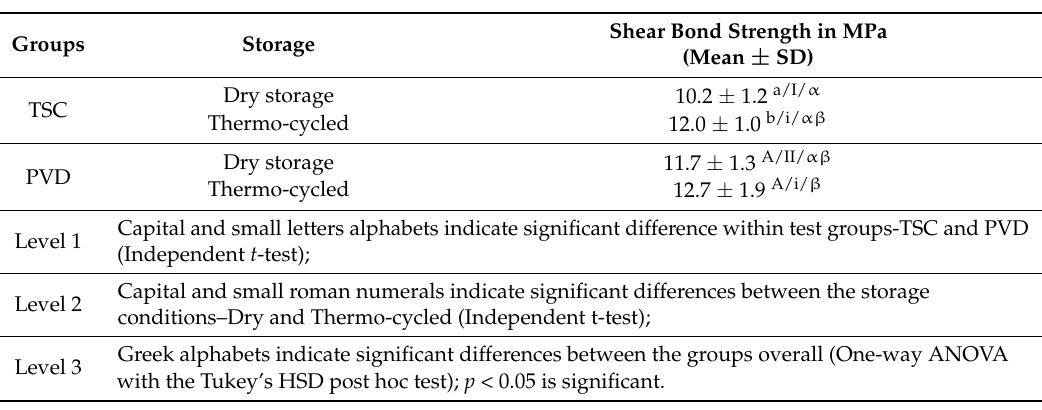
Table 1. The mean and standard deviation values of the shear bond strength of TSC and PVD-coated zirconia under different aging